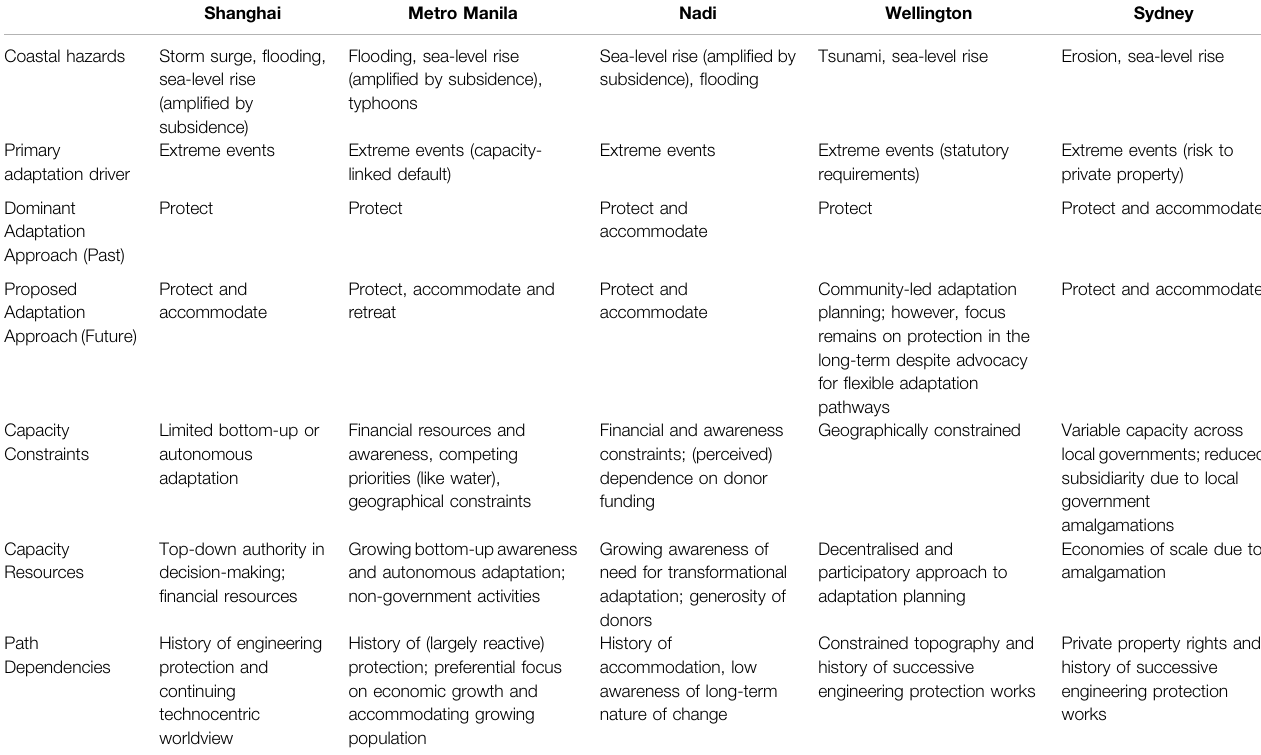
TABLE 1 | Comparison of case